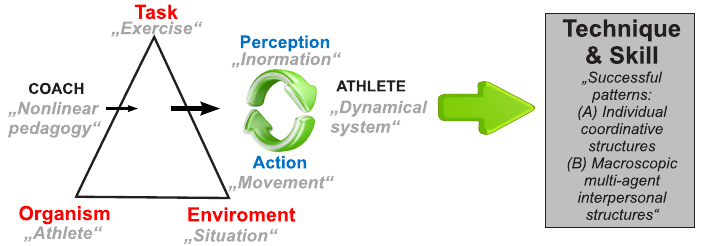
Figure 1. The constraints-led approach of technical education in sport (based on